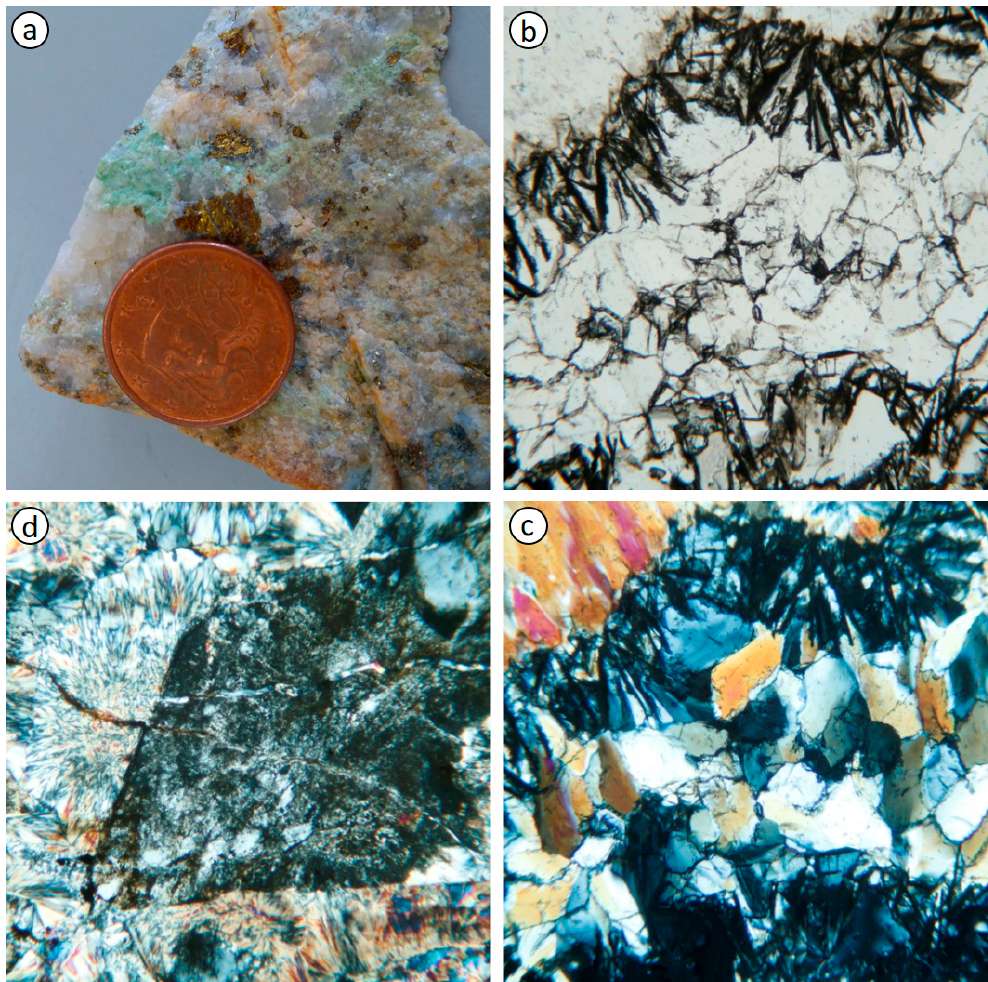
Figure 3. ( a ) Representative hand specimen of a (Ca,REE)-fluorcarbonate-bearing rock from Cinquevalli Mine. (Ca,REE)-fluorcarbonates are recognizable by the pale green color. Oxidized chalcopyrite (gold metal luster), quartz (white) and K-feldspar (pink) can also be recognized. The latter, however, is overestimated by visual inspection, because most of the reddish color is due to oxides and hydroxides that alter sulphides. ( b ) Photomicrograph (plain polarized light; 50X) showing bands of needle-like, randomly oriented crystals of (Ca,REE)-fluorcarbonates (dark) embedded in quartz. ( c ) Related cross polarized light photomicrograph. ( d ) Photomicrograph (cross polarized light) of coarse, euhedral K-feldspar (center) altered by white mica and bordered by ribbons of fibrous quartz (chalcedony). Photomicrograph side ∼ 9 mm. Table 1. EDXRF Bulk Composition (wt%) of a Representative Fluorcarbonate-Bearing Quartz Dike Sample.